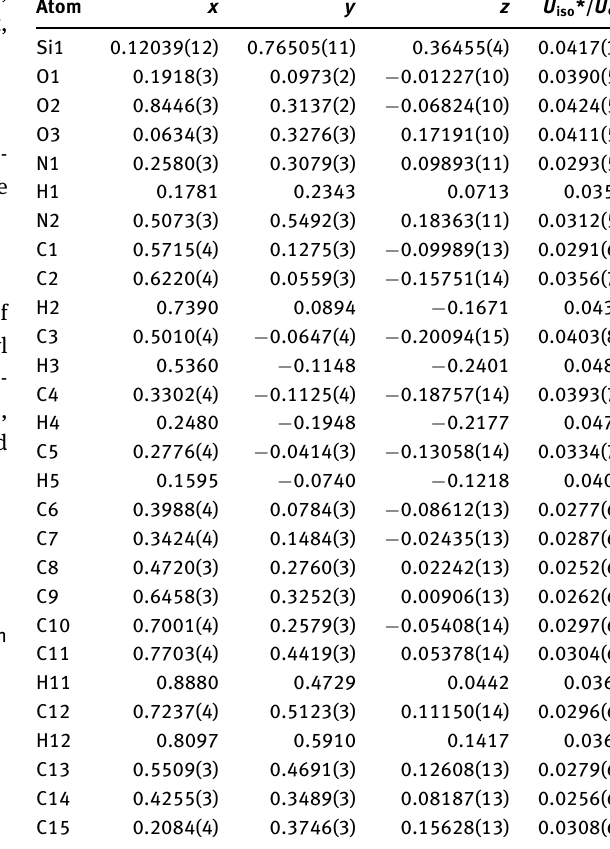
Table 2: Fractional atomic coordinates and isotropic or